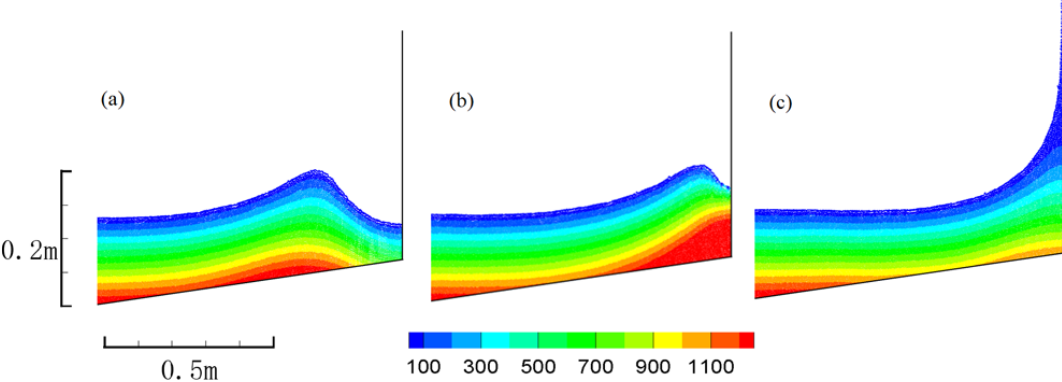
Fig. 6. Snapshots of SPH results (case B) of wave approach and impact on the wall and pressure distribution at time instances (a) 17.6s, (b) 17.7s, (c) 17.85s.